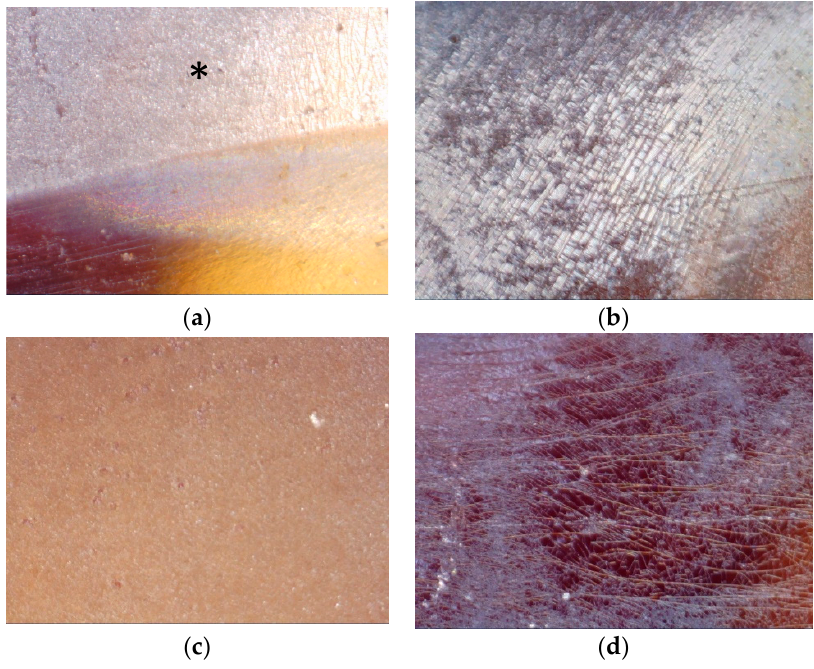
Figure A4. Optical microphotograph (2 × 1.5 mm) of EPDM rubber after 5 × 10 15 ions/cm 2 PIII, ( a ) the edge of the mask (* marks the treated area). ( b – d ) are in a center of the treated area.